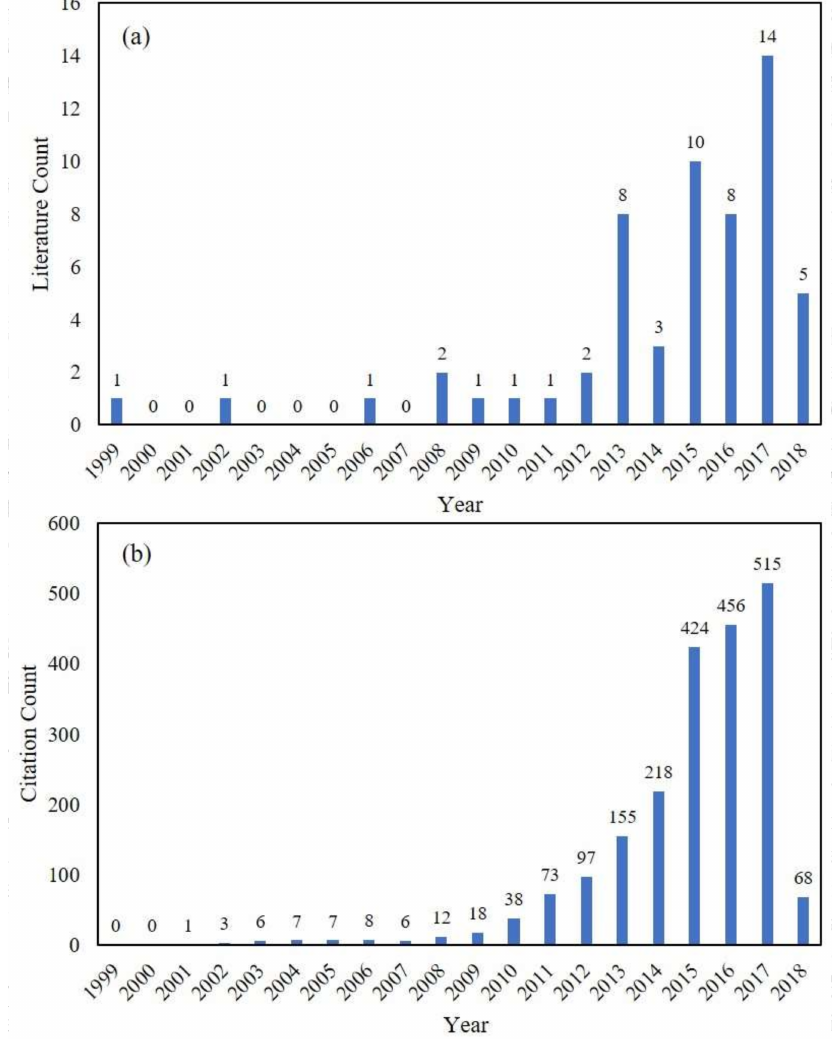
Figure 2. ( a ) Yearly literature counts of journal papers introducing spatiotemporal data fusion methods and ( b ) citation counts of these papers in Web of Science. The search was conducted on 10 March